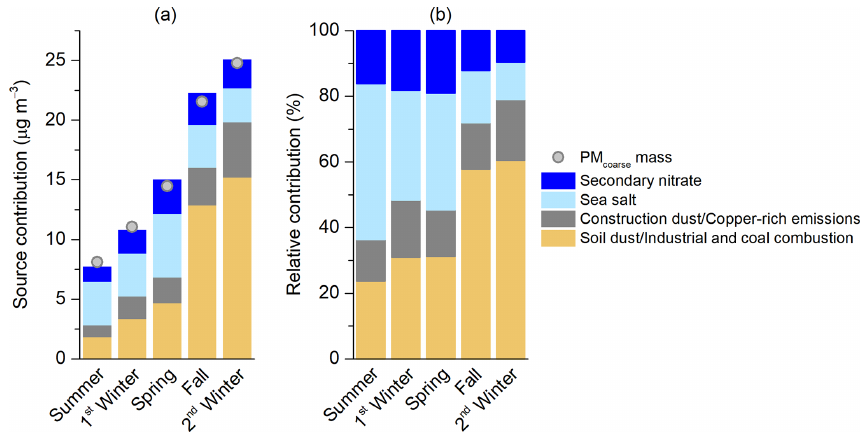
Figure 4. Source contributions to PM coarse during the study period. Panel (a) shows the results in µgm − 3 , while (b) shows the results in percentage share. The circle markers in (a) represent the PM coarse concentration measured by gravimetric analysis.